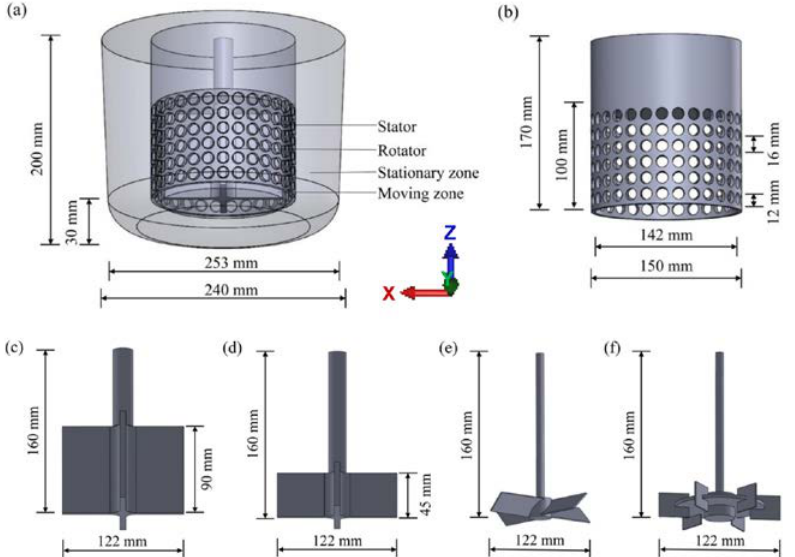
Figure 1. Geometries and dimensions of the stirred tank and agitators; ( a ) computational domain of the stirred tank; ( b ) the stator of the rotor-stator agitators; ( c ) the rotor of the CSRS agitator; ( d ) the rotor of the HCSRS agitator; ( e ) A200 agitator; ( f ) Rushton turbine